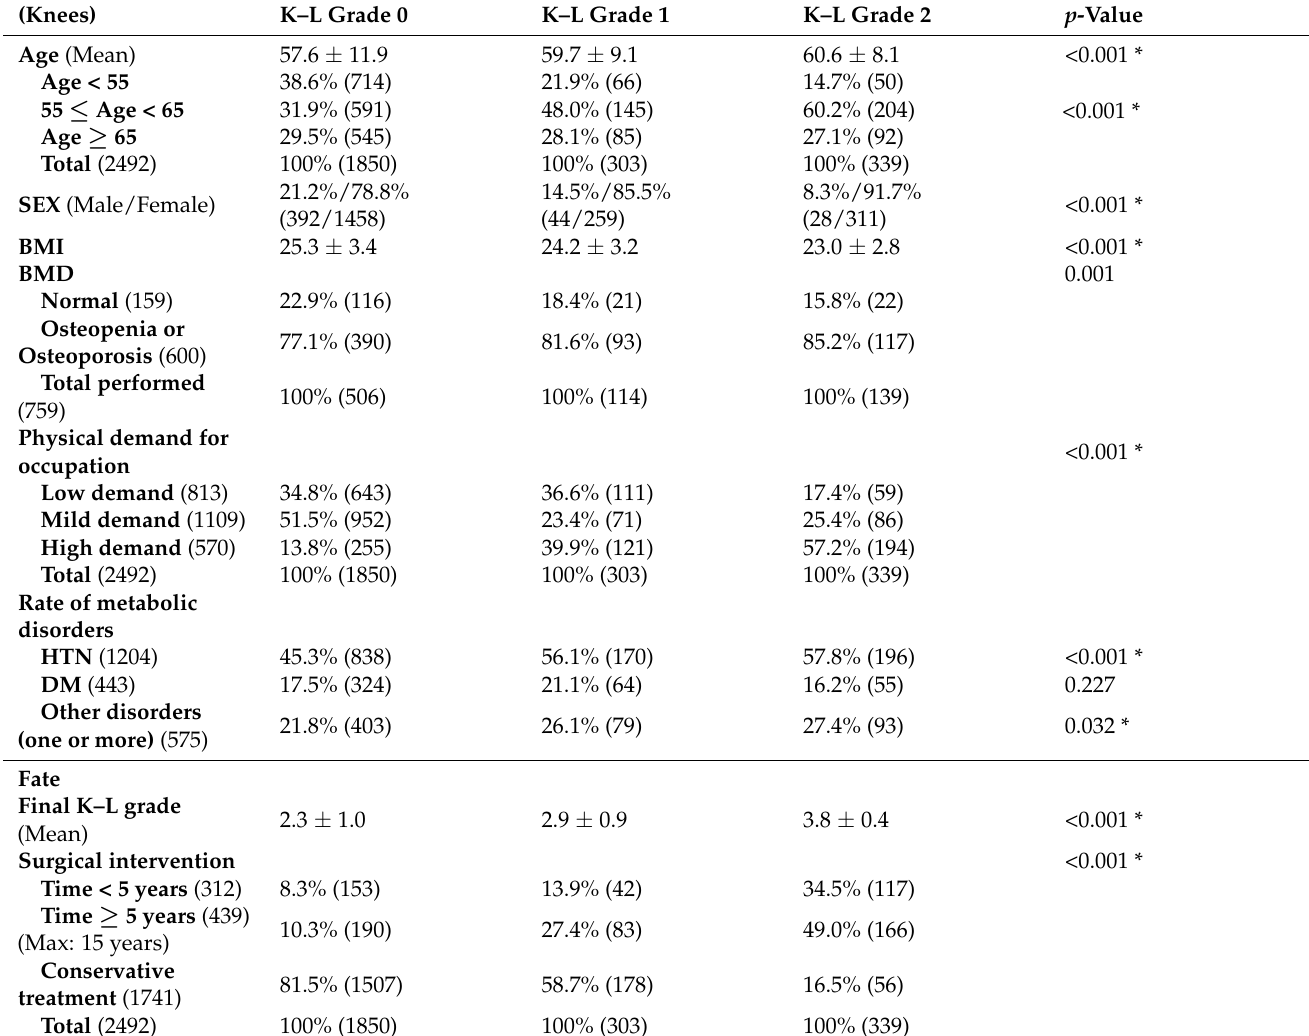
Table 1. Patient-specific situations and fate according to the initial K–L